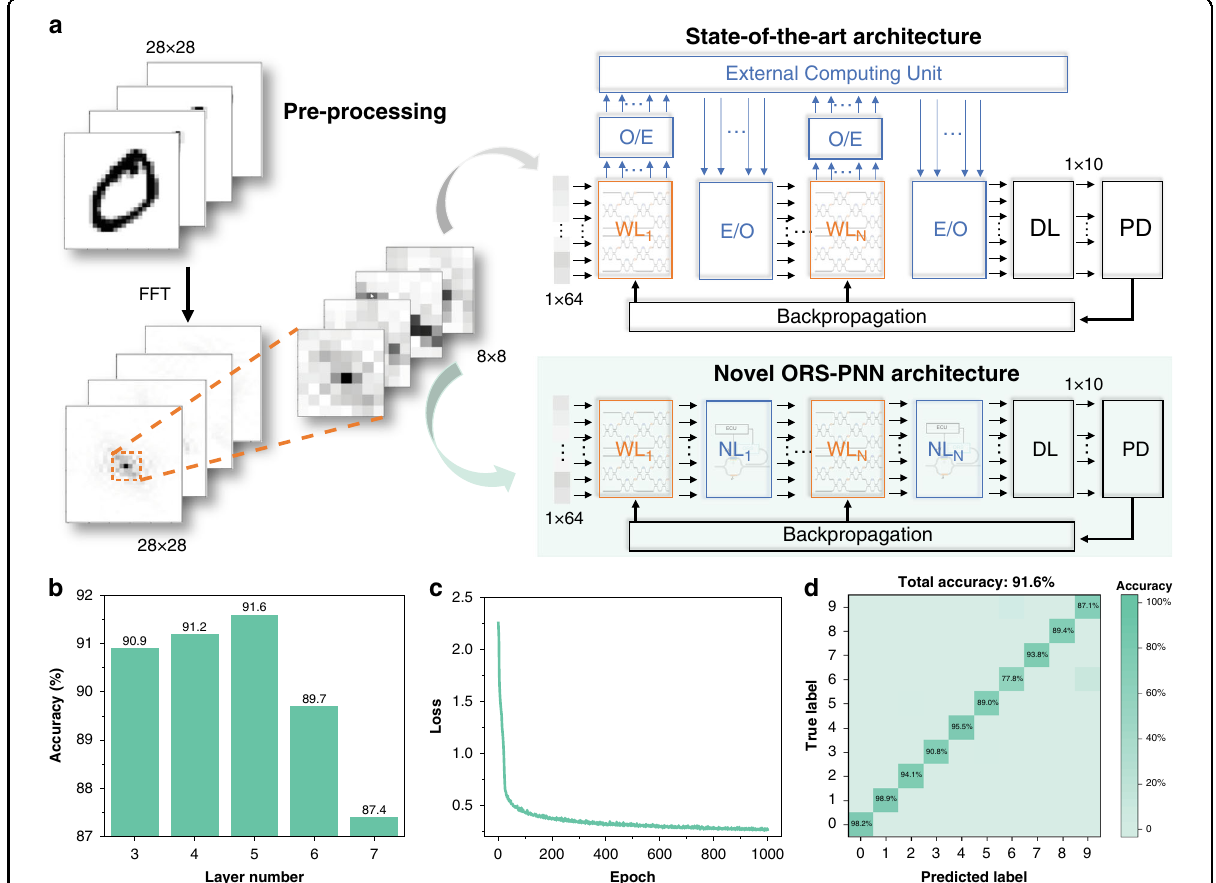
Fig. 5 Photonic neural network with nonlinear accelerator. a Schematic illustration of MNIST handwritten digit classi fi er based on photonic neural network accelerated by Opto-Resistive RAM Switch-based nonlinear accelerator. b the testing accuracy of photonic neural network architecture on MINST dataset, as a function of layer number. c The calculated loss at each epoch during the learning procedure with fi ve layers. d The confusion matrix of photonic neural network. (ORS-PNN Photonic Neural Network with Opto-Resistive RAM Switch-Based Nonlinear Accelerator, O/E Optical-to-Electrical Convertors, E/O Electrical-to-Optical Convertors, WL Weighting Layer, NL Nonlinear Layer, DL Drop Layer, PD